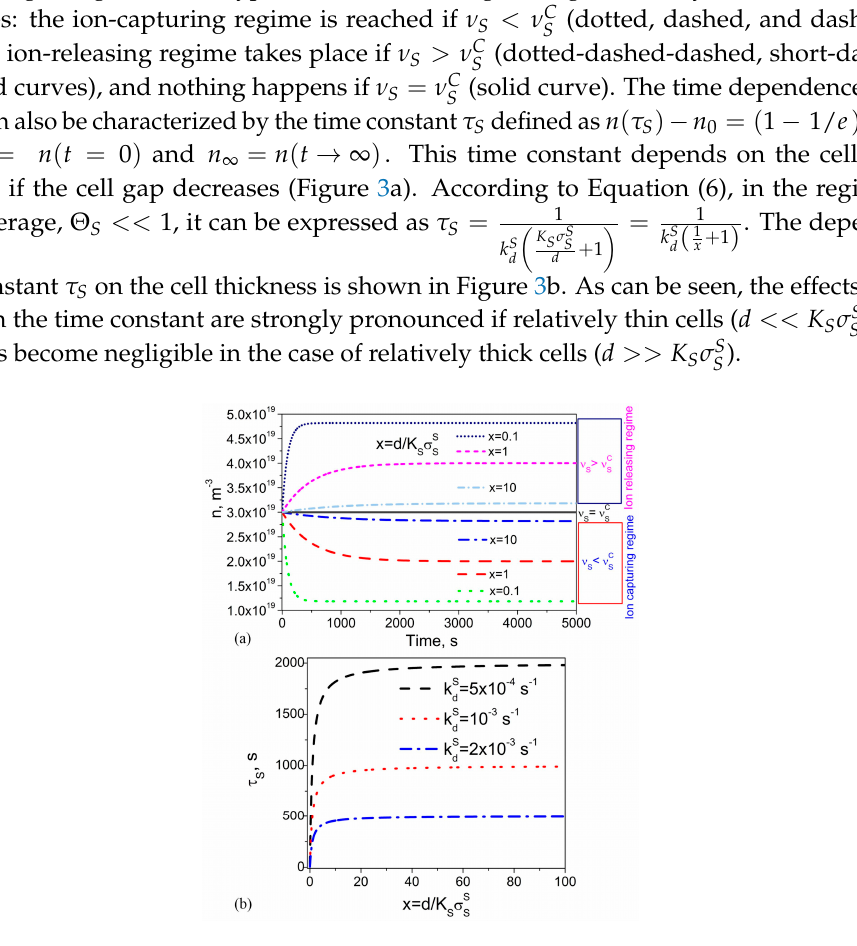
Figure 3. ( a ) The volume concentration of mobile ions n versus time calculated using different values of the dimensionless parameter x proportional to the cell thickness ( x = d ). The ionic contamination of substrates is quantified by means of the contamination factor ν S ( v S = 10 − 3 (dotted, dashed, and dotted-dashed curves); v S = 3 × 10 − 3 (solid curve); v S = 5 × 10 − 3 (dotted-dashed-dashed, short-dashed, and short-dotted curves)). Other parameters used in simulations: K S = 10 − 22 m 3 , k = 10 − 3 s − 1 , σ S = 10 17 m − 2 , n = 3 × 10 19 m − 3 ; ( b ) The time constant τ S as a function of the dimensionless parameter x calculated at different values of the desorption rate coefficient, = 5 × 10 − 4 s − 1 (dashed curve); k S = 10 − 3 s − 1 (dotted curve); k S = 2 × 10 − 3 s − 1 k S ( k S d d d d (dashed-dotted